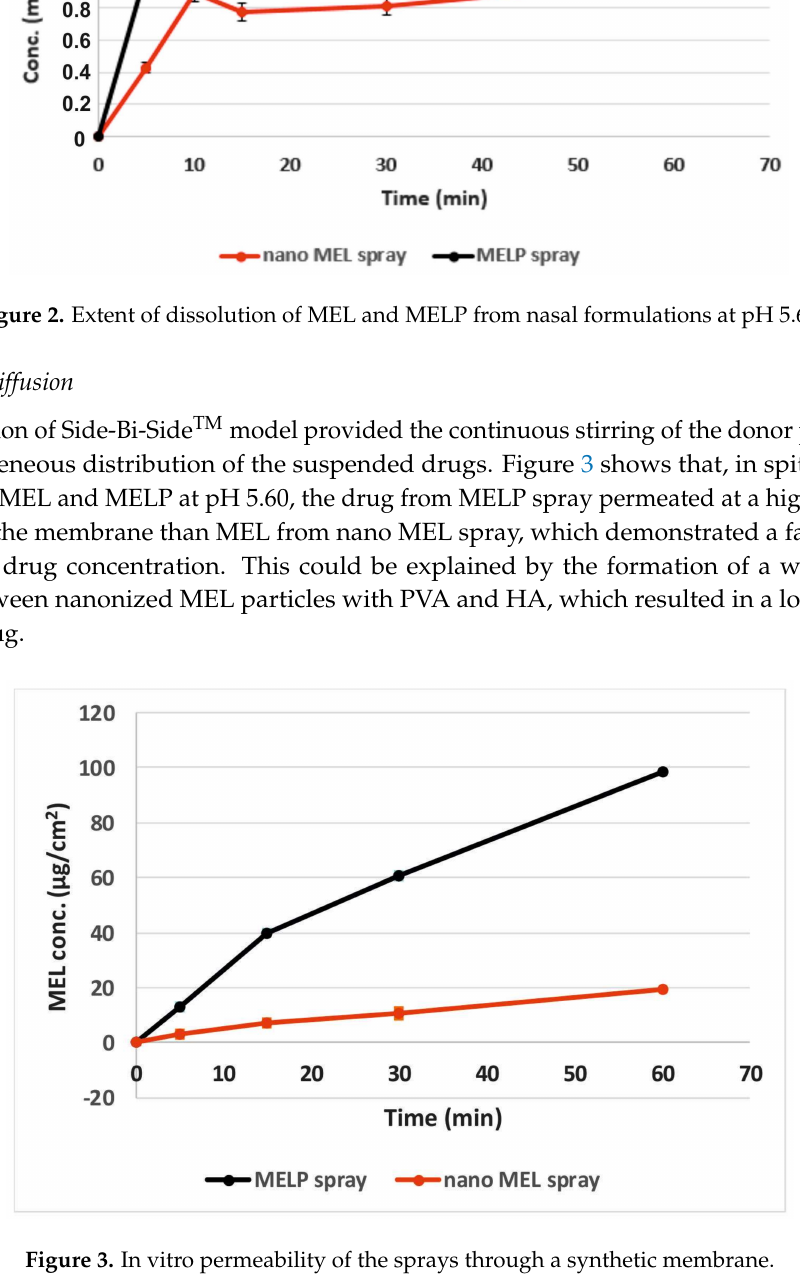
Figure 3. In vitro permeability of the sprays through a synthetic